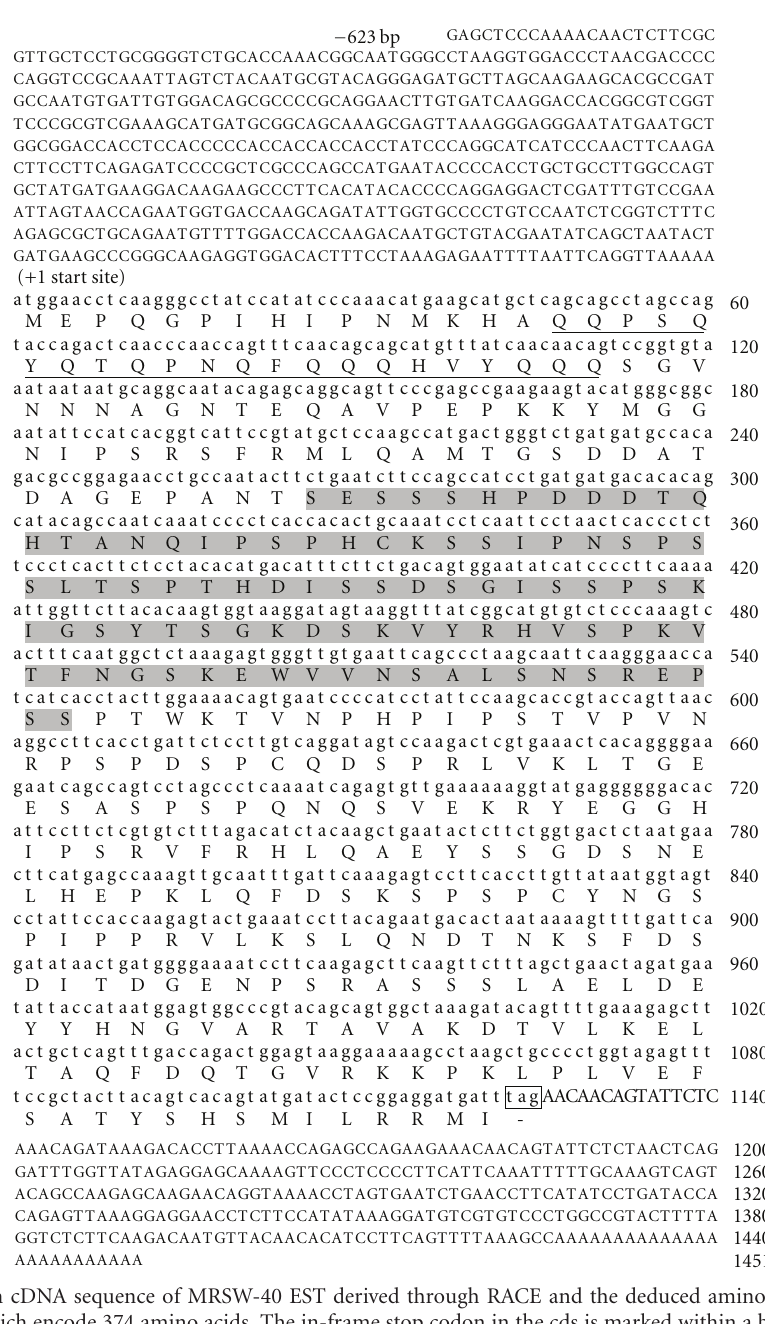
Figure 3: The full-length cDNA sequence of MRSW-40 EST derived through RACE and the deduced amino acid sequence . The ORF is shown in small letters which encode 374 amino acids. The in-frame stop codon in the cds is marked within a box. The 5 (cid:4) - and 3 (cid:4) -UTR are shown in capital letters. The identified glutamine-rich domain is underlined, and the serine-rich motif is shaded within gray box.